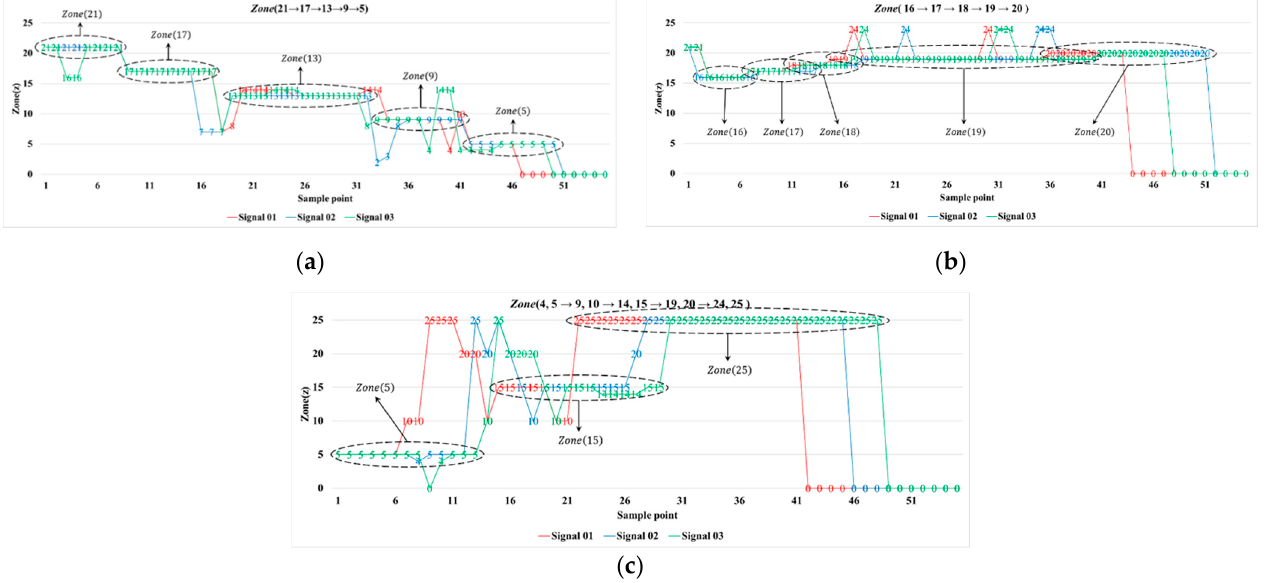
Figure 6. Feature PIR signals: ( a ) Route 01, ( b ) Route 02 and ( c ) Route 03.